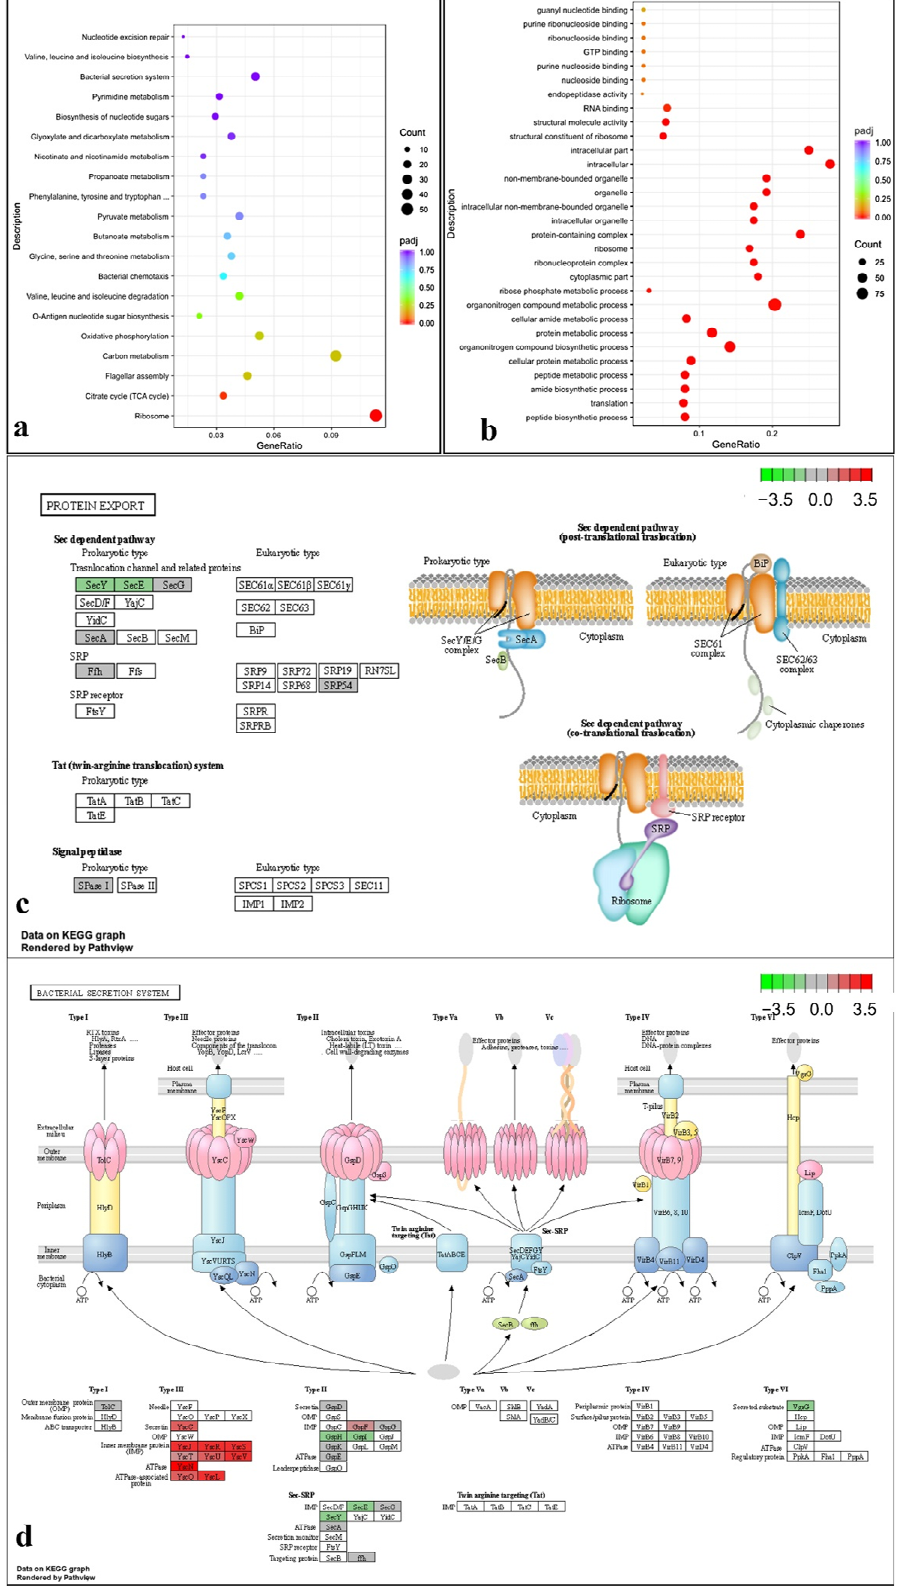
Figure 9. Functional classification and enrichment of genes that showed differential expression between the hcp mutant and the WT strain of Acidovorax citrulli by ( a ) KEGG (Kyoto Encyclopedia of Genes and Genomes) and ( b ) GO (Gene Ontology) analyses. The expression of some genes for protein export ( c ) and secretion systems ( d ) in KEGG pathways were affected.